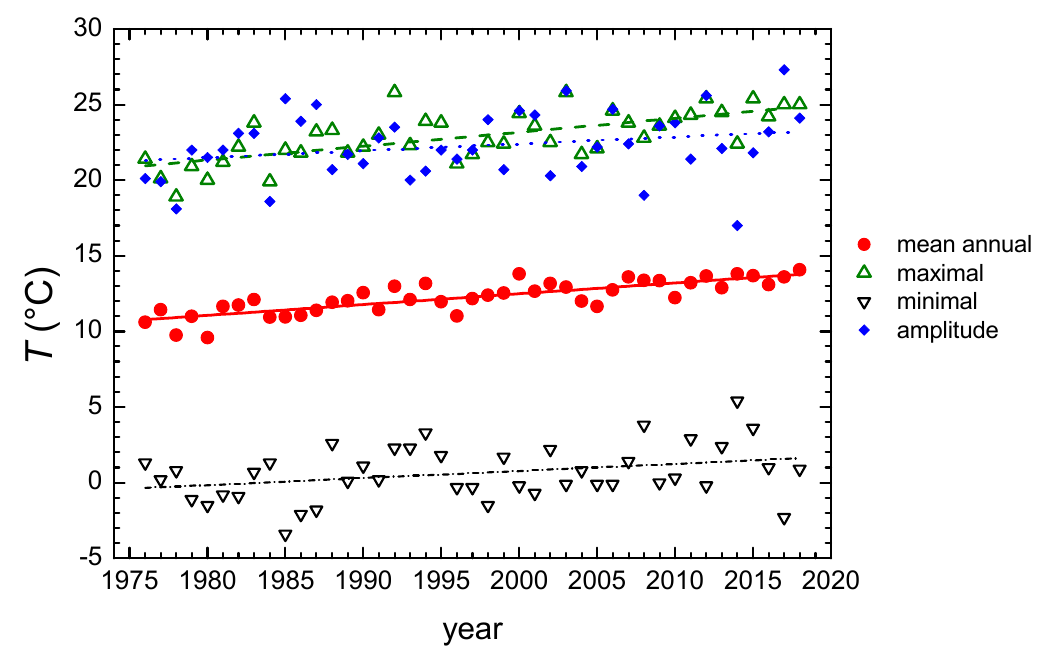
Figure 7. Mean annual temperature, minimaland maximal monthly temperatures within a year, and the temperature amplitudes in Zagreb, 1976–2018 period. Trend lines for each dataset are shown in the same